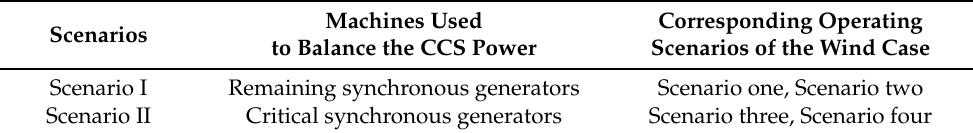
Figure 6. A constant current source (CCS) integrated into the grid. Table 2. Two operating scenarios of the CCS